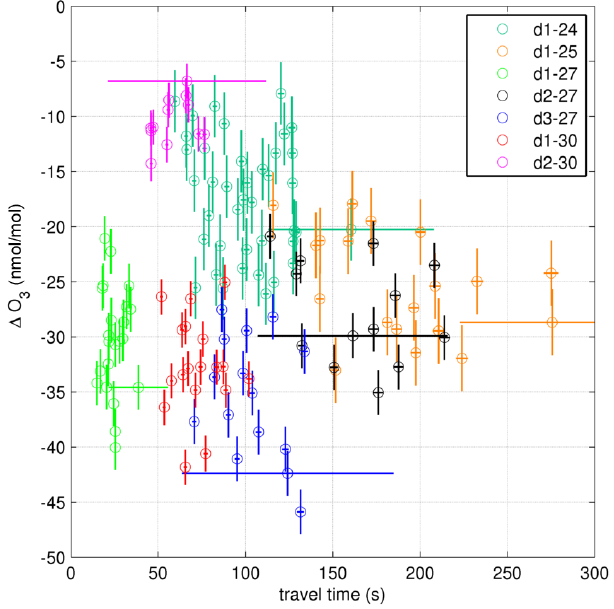
Figure 4. (cid:49) O 3 against calculated processing time at the in-plume measurement sites. Error bars are 1 standard deviation, accounting for both variance in the values over the 120s of each bin and known errors of the instruments.